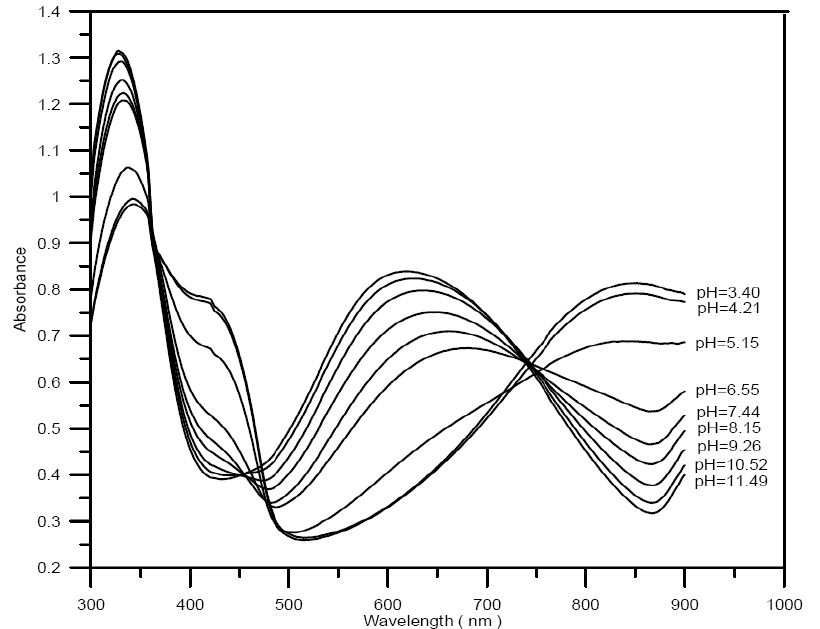
Figure 1. Set of absorption spectra recorded for PANI film in buffer solutions of different pH. Reprinted from [21] © 2007 with permission from